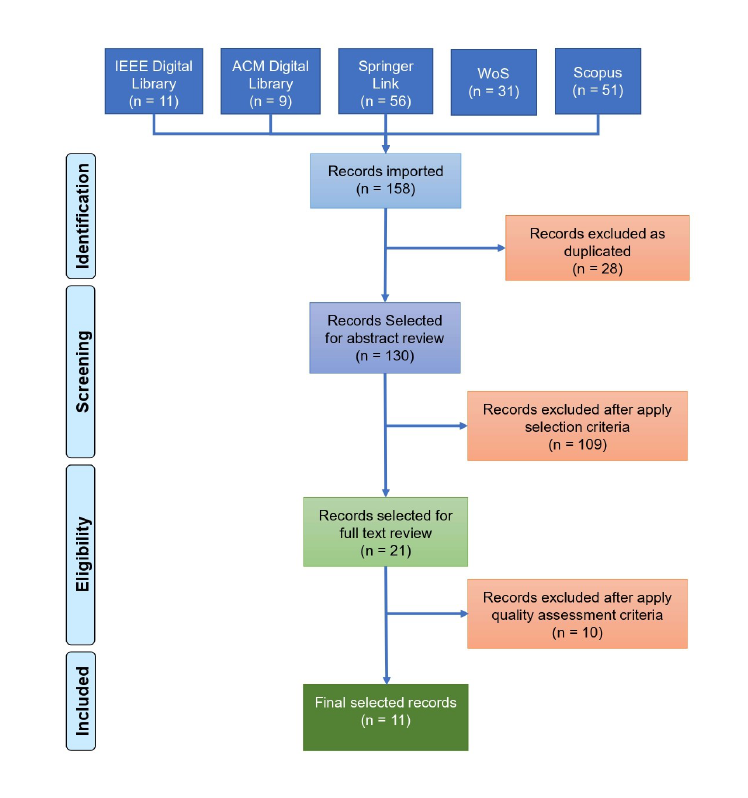
Figure 3. Results of the conduction process. Source: author. Table 10. Quality Assessment